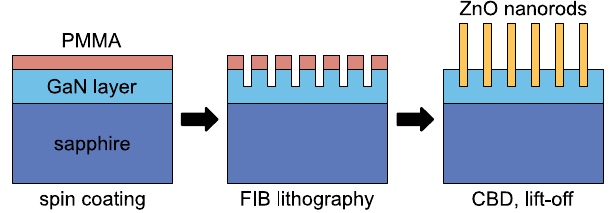
Figure 1. Flowchart of the fabrication process. The GaN epitaxial layer grown on sapphire substrate was covered by poly(methyl methacrylate) (PMMA) layer. First, the array of circular holes was created into the substrate by focused ion beam (FIB) lithography. Then, the ZnO nanorods were grown from the openings using chemical bath deposition (CBD) technique. Finally, the PMMA mask was